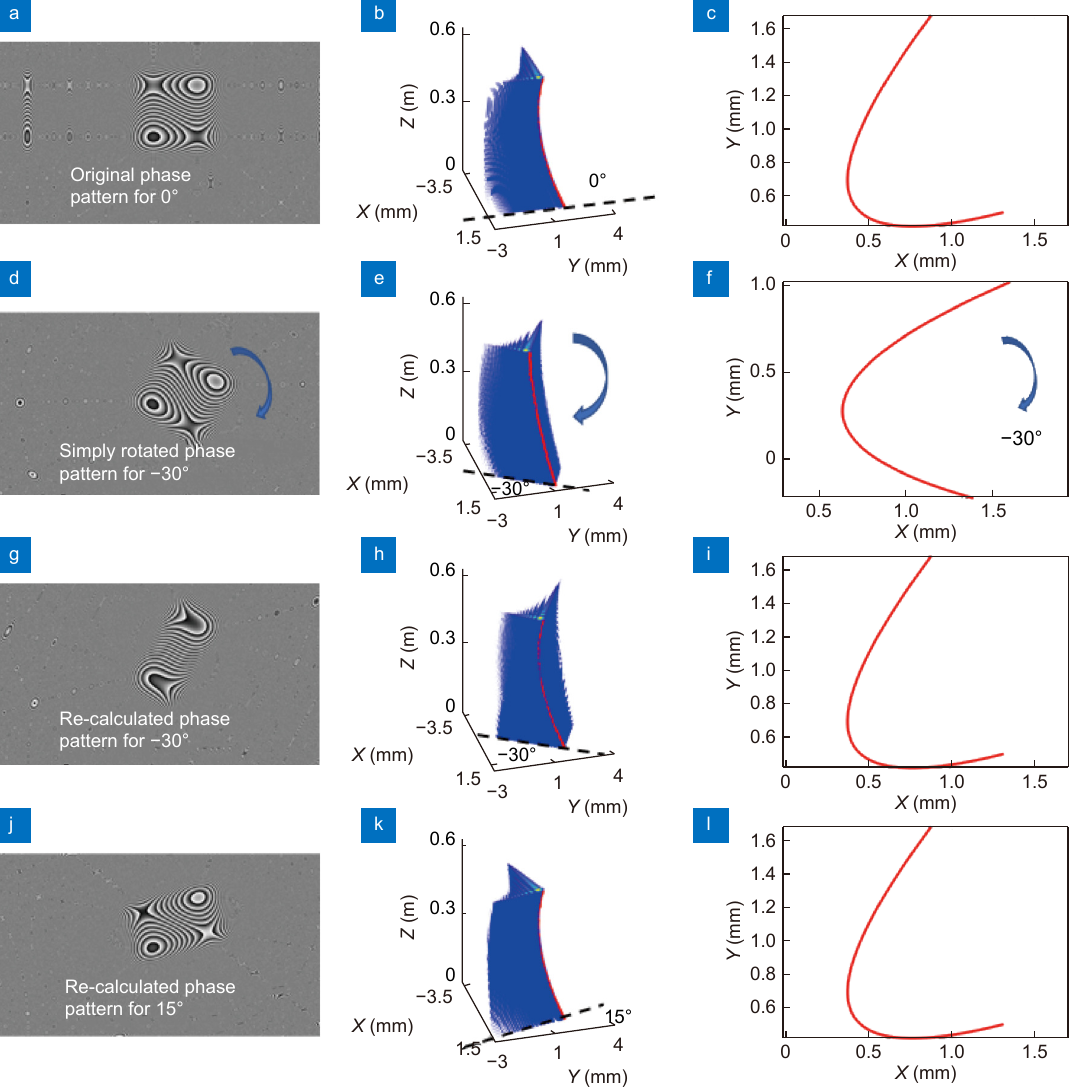
Fig. 3 | Different phase patterns and their calculated 3D optical distribution and trajectories. ( a ) Original phase pattern and its ( b ) 3D optic- al distribution and ( c ) the projection of trajectory. ( d ) Simply rotated phase pattern for -30° and corresponding ( e ) 3D optical distribution and ( f ) the projection of trajectory. ( g ), ( j ) Re-calculated phase patterns for -30° and 15°, and ( h ), ( k ) their 3D optical distribution and ( i ), ( l ) the projection of